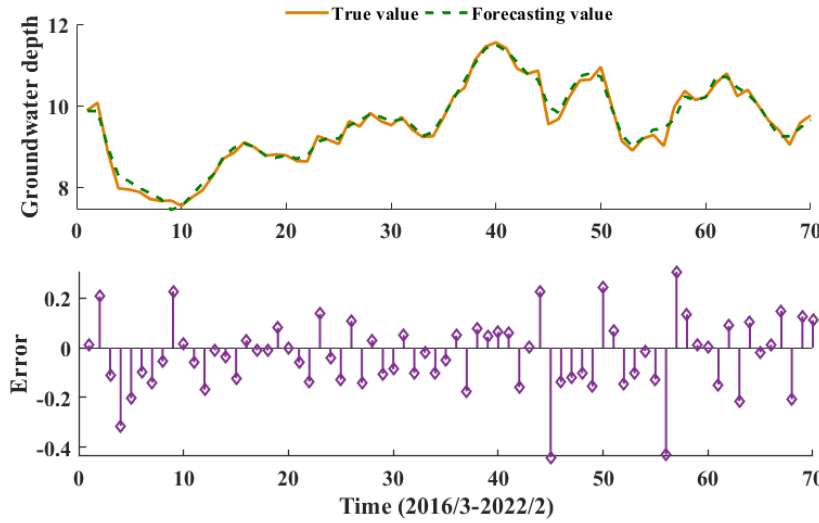
Figure 8. Predicted results for each component.